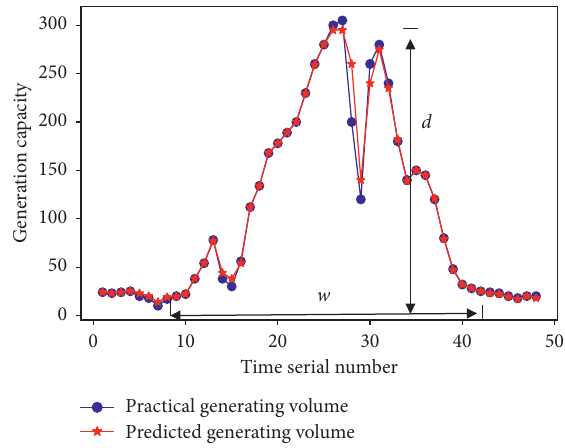
Figure 8: One-day power generation forecast in summer.